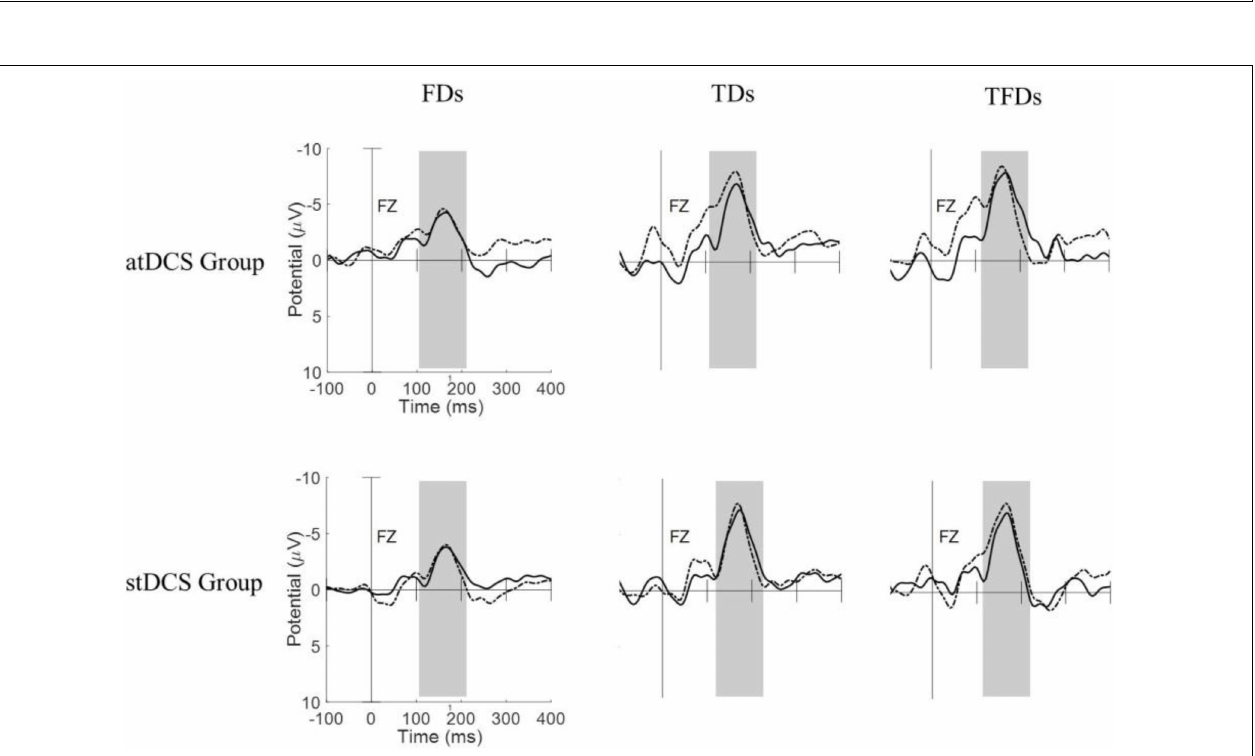
FIGURE 1 | Responses of the three types of deviation stimuli (FDS, TDS, and TFDS) from pre- and post-tDCS states in the two groups of subjects (atDCS group and stDCS group). Dashed line = pre-tDCS, solid line = post-tDCS.